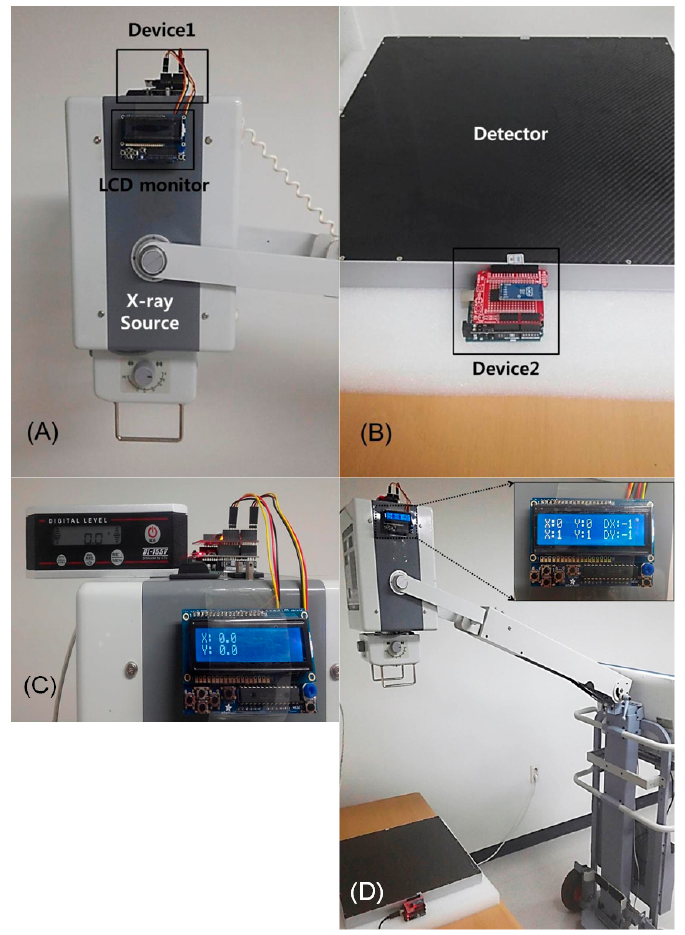
Figure 3. Details of the device for obtaining the SDA, which was attached on an X-ray source ( A ) and a detector ( B ). Photography showed the initial setting for obtaining the angle degree using the SDA device and digital angle meter ( C ). The ‘0.0°’ value on the SDA device was accordant with a